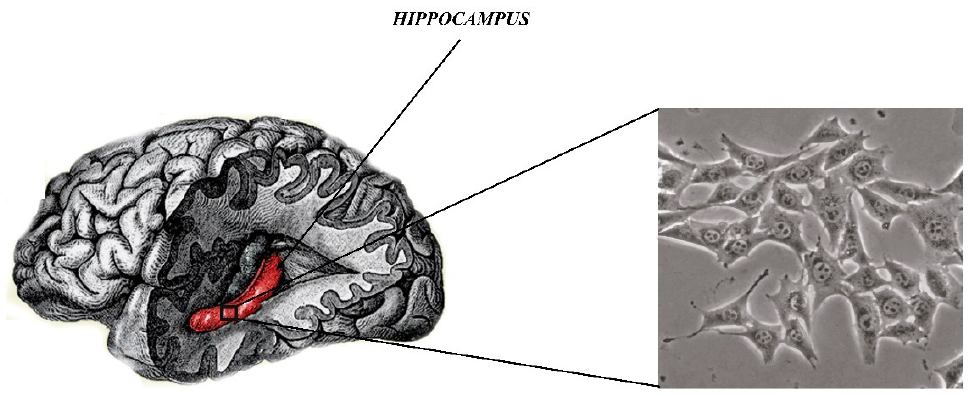
Figure 3. Mouse hippocampal neurons (HT22) cells.